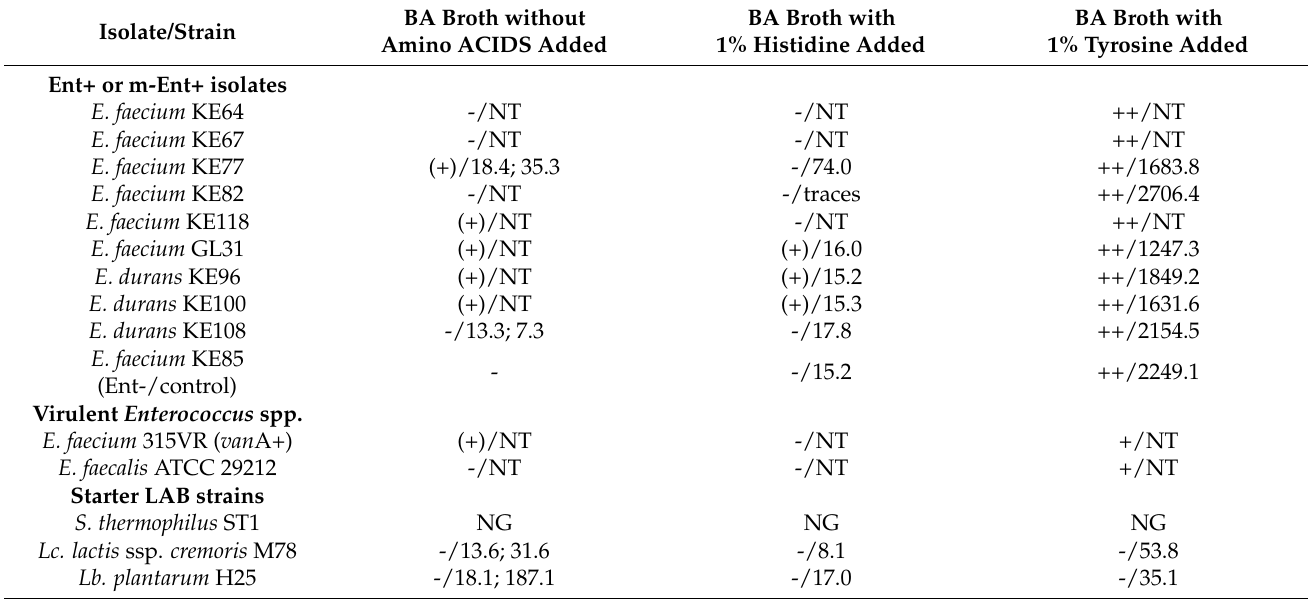
Table 4. Detection and HPLC-based quantification (mg/L) of histamine (HIS) and tyramine (TYR) formed in vitro by pure cultures of the Enterococcus cheese isolates in improved biogenic amine (BA) broth [36] after culturing at 37 ◦ C for 72 h 1 . BA Broth without Isolate/Strain Amino ACIDS